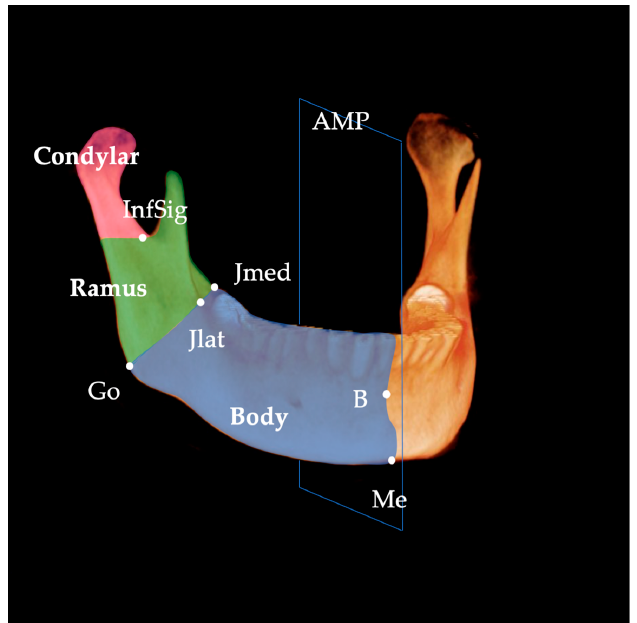
Figure 7. Three divisions of the mandible. Infsig, lowest point of the sigmoid notch; Me, menton; B, supramentale; Jlat, junction lateral; Jmed, junction medial; Go, gonion.